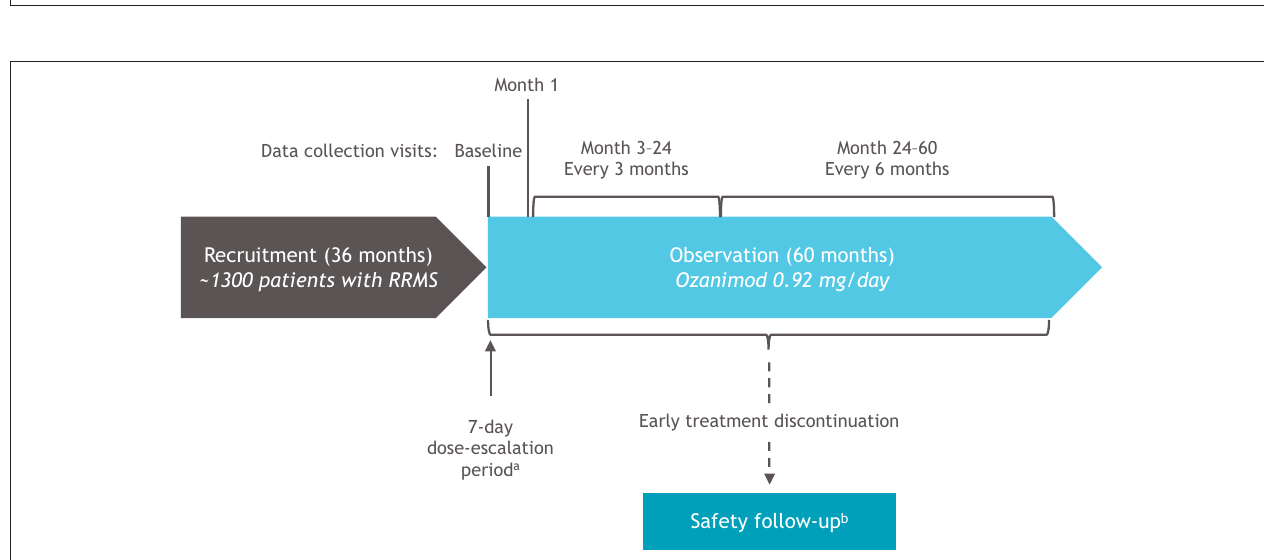
FIGURE 2 | OzEAN study design. MS, multiple sclerosis; RRMS, relapsing-remitting multiple sclerosis. a Days 1–4: ozanimod 0.23mg; days 5–7: ozanimod 0.46mg; days 8 and thereafter: ozanimod 0.92mg. b Patients who discontinue ozanimod prior to end of study (month 60) will be withdrawn from the OzEAN study and a safety follow-up will be performed 3–8 months after the last dose of ozanimod when a new therapy for MS is started or after 8 months (at the latest) if no subsequent MS therapy is initiated.